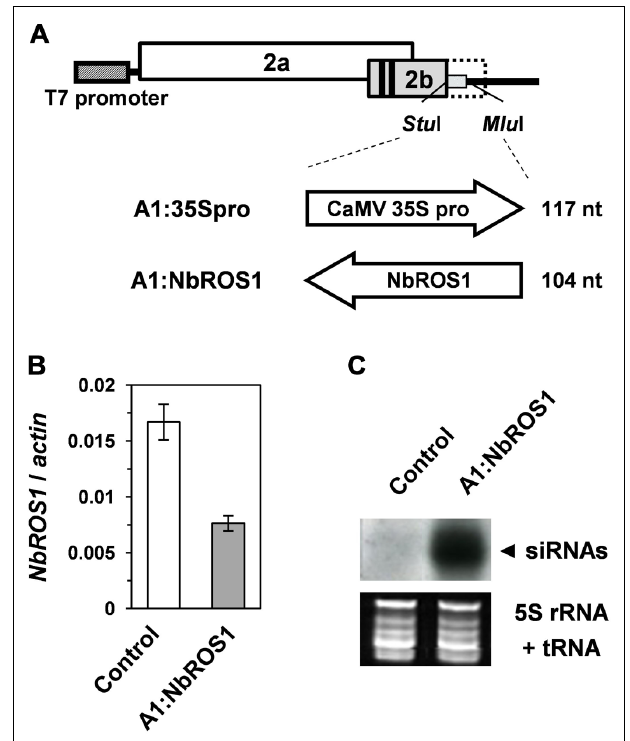
FIGURE 2 | Gene silencing using the CMV-A1 vector. (A) Schematic representation of the vector constructs targeting the CaMV 35S promoter or the NbROS1 -coding sequence. (B) Changes in mRNA level of NbROS1 as a consequence of infection with virus that contains the NbROS1 insert (A1:NbROS1).The NbROS1 mRNA level was assessed relative to the actin mRNA level in leaf tissues at 18 days post-inoculation (DPI). Data are the means and standard errors obtained from three replicates. (C) Northern blot analysis of low-molecular weight RNAs isolated from leaf tissues of plants infected with the recombinant CMVs at 18 DPI, probed for the NbROS1 gene. Ethidium-bromide-stained 5S rRNA and tRNAs bands are shown below the panel to show that an equal amount of the small RNA fraction was loaded. In the experiments in (B,C) , both the control and A1:NbROS1-infected plants were infected with A1:35Spro to eliminate non-specific effects of viral infection on the mRNA level of NbROS1